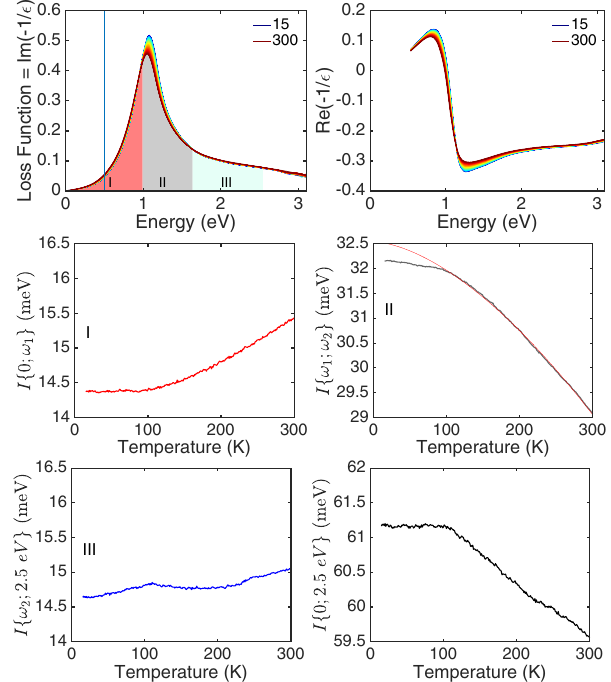
FIG. 11. Sample Bi2212-91-OpD. Caption details as in Fig. 8. The value of the fitted exponent α is 2.2.